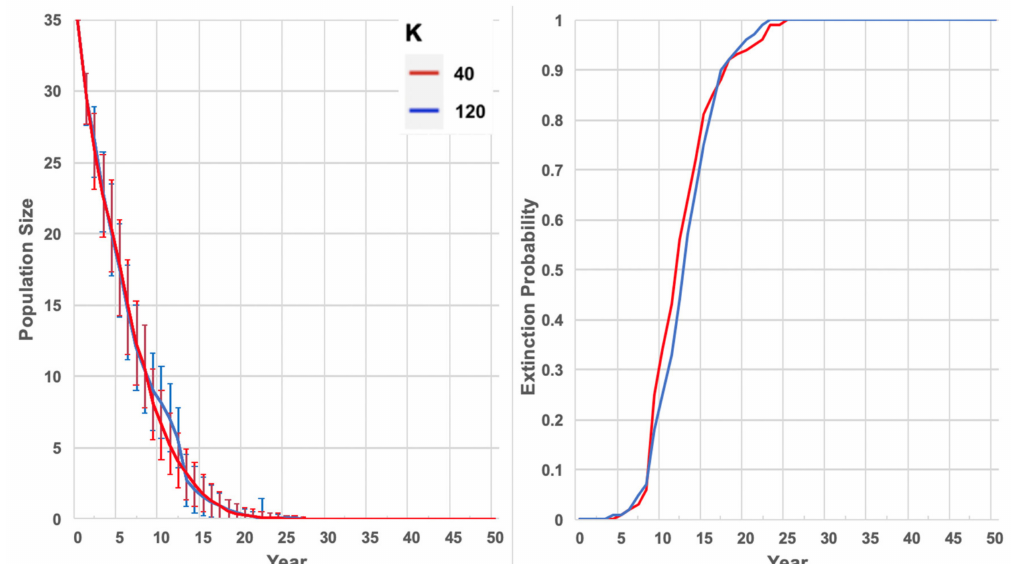
Figure 3. The mean population size ( ± 1 SD) and probability of extinction averaged across 200 replicate simulations, beginning with 35 individuals in Yellingbo with inbreeding depression effects included in the models. The extinction probability is given as the proportion of simulations that had gone extinct by each year, with extinction defined as only individuals of one sex remaining. Simulation settings are given in Table 1 ( 2019 Trajectory